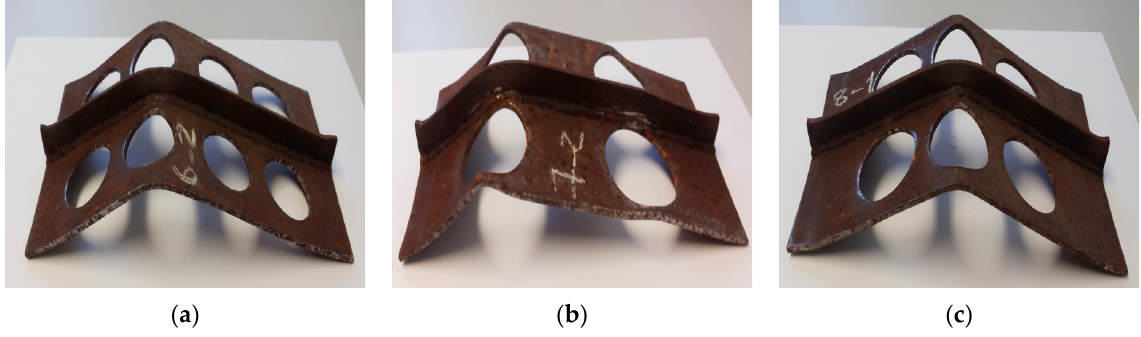
Figure 9. Post-collapse deformed shape for n = 8, 6, 4 DoO = 28.30%, SP-NS6-2 ( a ), SP-NS7-2 ( b ) and SP-NS8-1 ( c ).